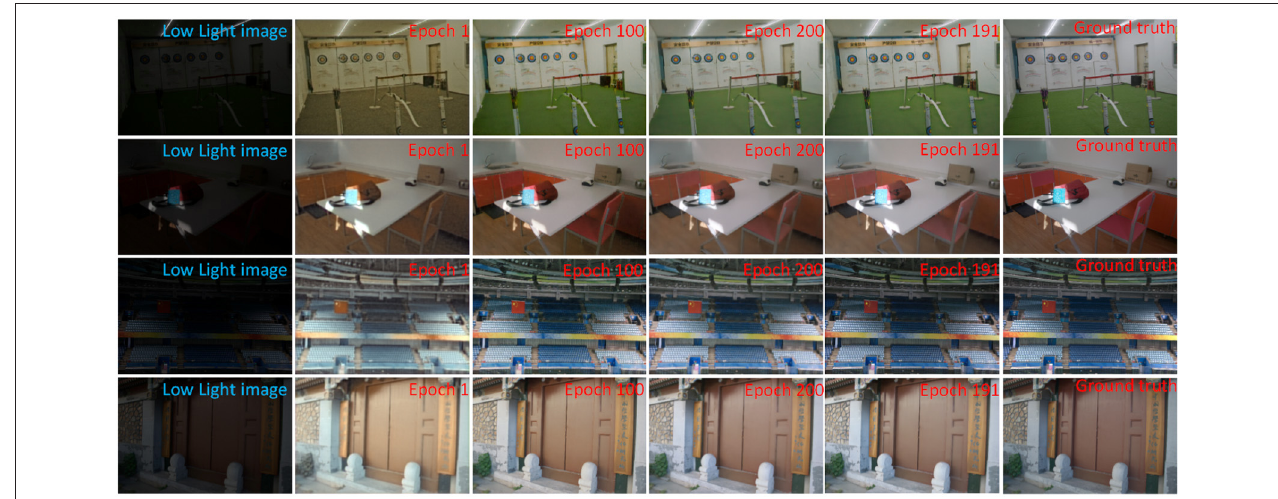
FIGURE 6 | The enhancement results of different epoch validation sets during